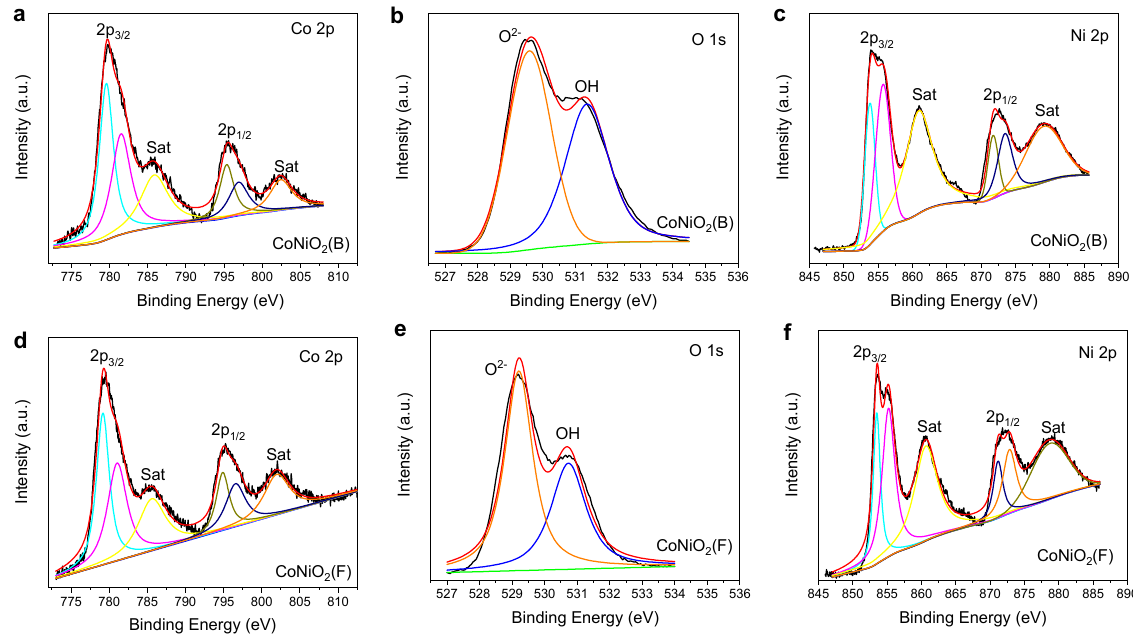
Figure 4. XPS spectra of CoNiO 2 (B) and CoNiO 2 (F). ( a ) Co 2p, ( b ) O 1s, and ( c ) Ni 2p XPS spectra of CoNiO 2 (B). ( d ) Co 2p, ( e ) O 1s, and ( f ) Ni 2p XPS spectra of CoNiO 2 (F).